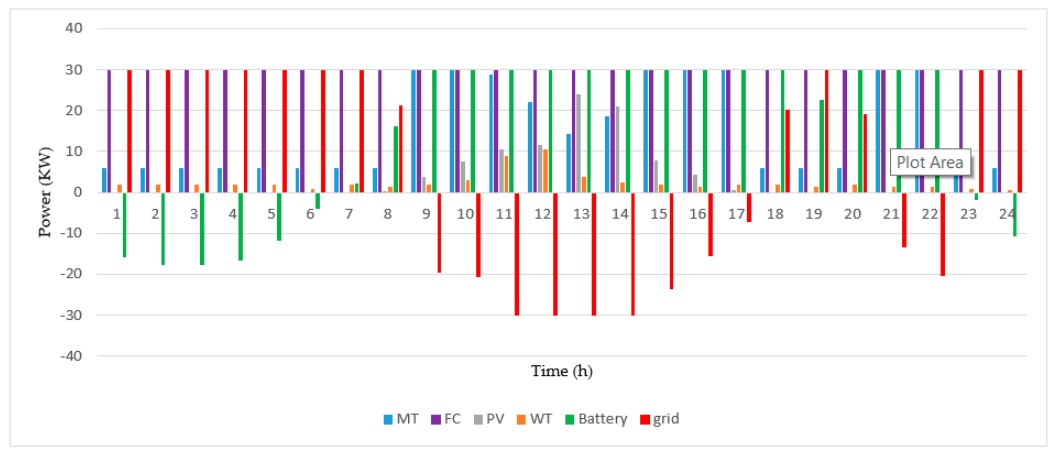
Figure 12. The optimal output power from the installed DG units for the first scenario.